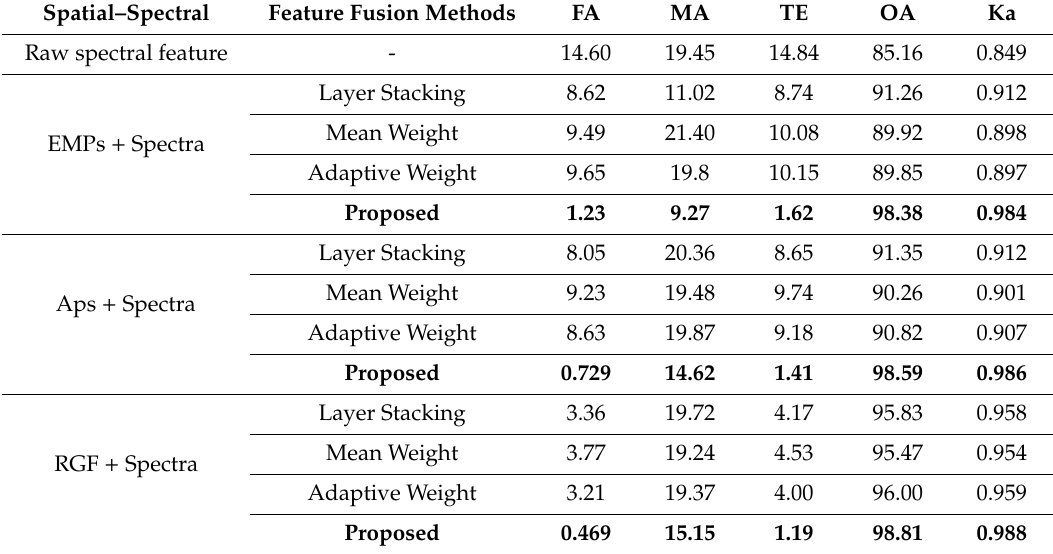
Table 5. Quantitative comparisons (%) between the proposed framework, the raw spectral feature, and different spatial–spectra features fusion methods for the Site A VHR bi-temporal remote sensing images.